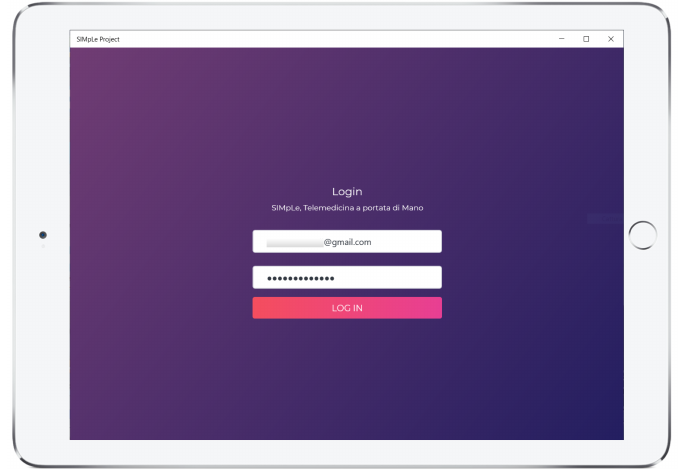
Figure 11. Login view for Windows, Adroid and IOS.